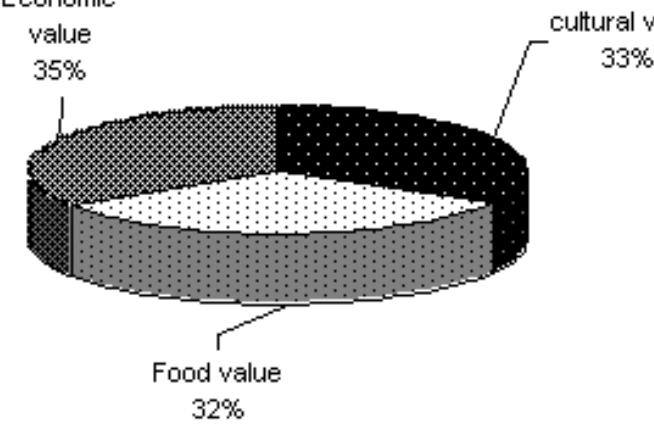
Fig 2 Contribution of indigenous agrobiodiversity in socio- cultural and economic life of the Monpa